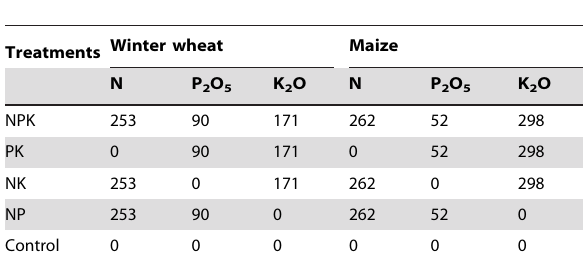
Table 2. Treatment and fertilizer nutrient rates (kg ha 2 1 ) applied to winter wheat and maize at Yucheng, Shandong Province of